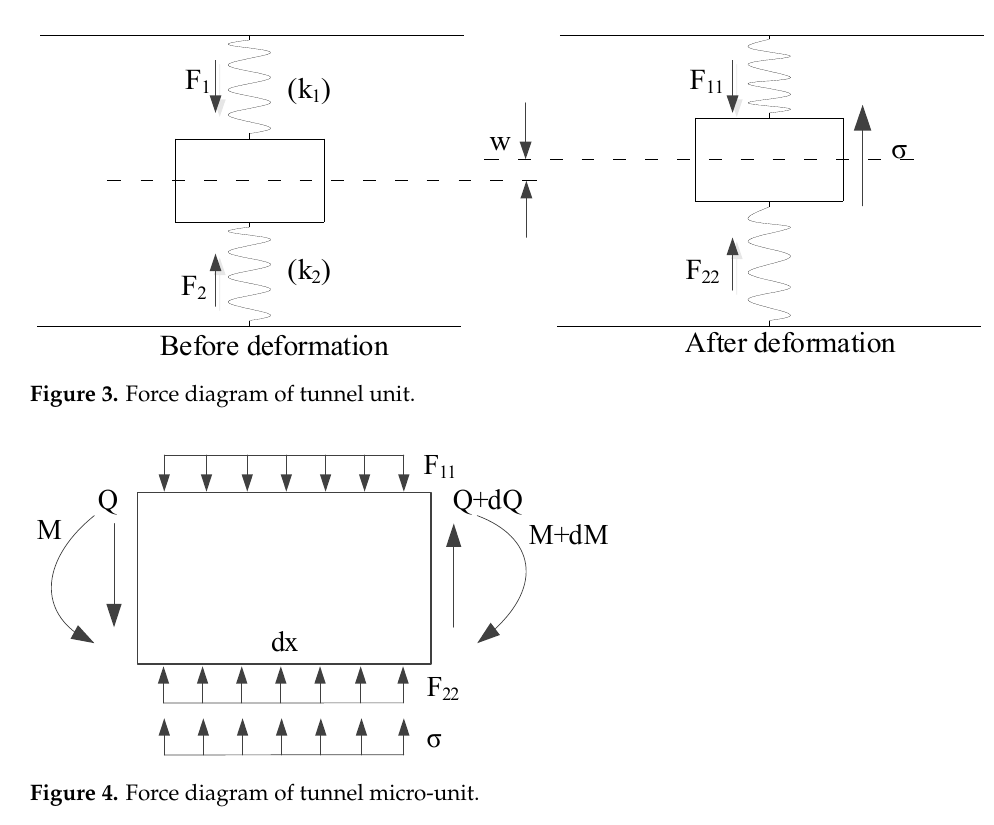
Figure 3. Force diagram of tunnel unit.